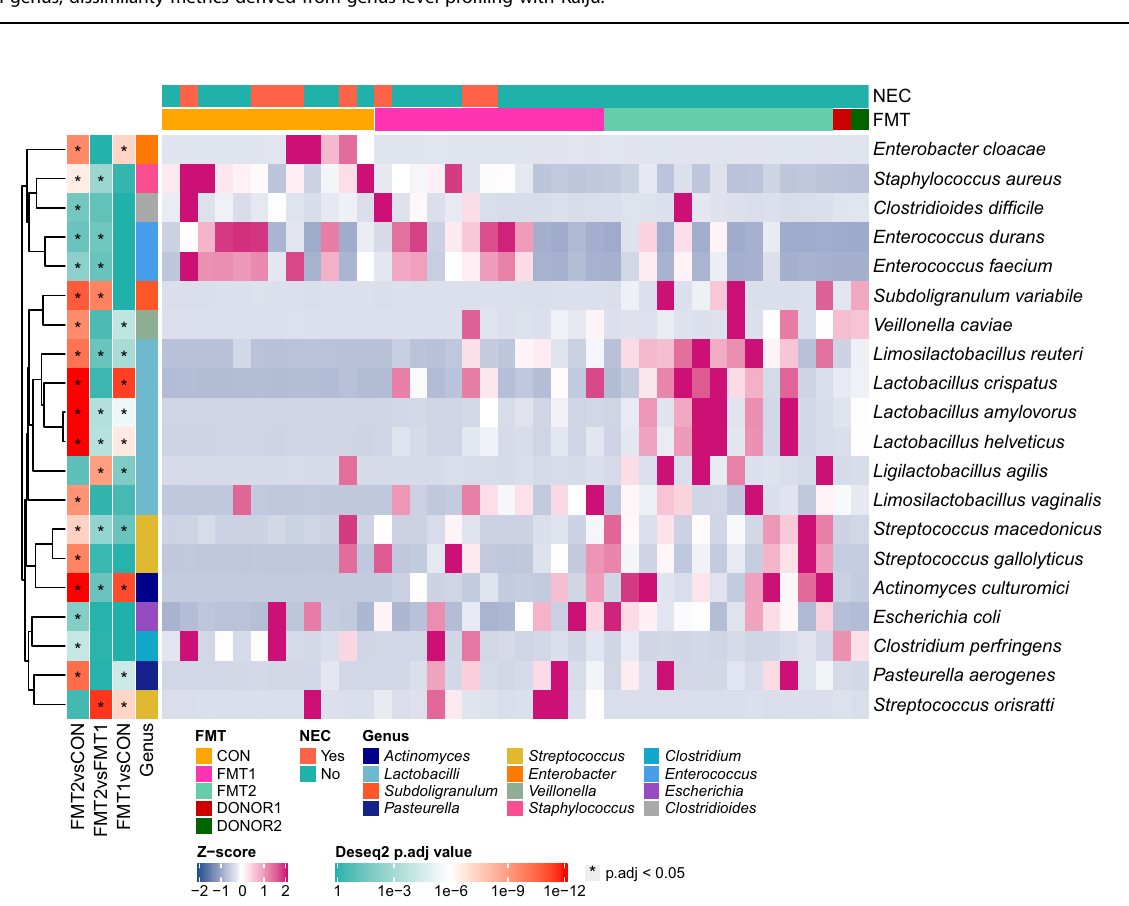
Fig. 4 Differentially abundant taxa in colon between recipient groups. Differentially abundant core species (relative abundance > 1% among at least 10% of samples) are shown. The label of * represents adjusted p < 0.05 (Wald test with Benjamin-Hochberg correction). Respectively n = 13, 13, 12 for FMT1, FMT2 and CON. FMT1 rectal FMT with Donor 1, FMT2 rectal FMT with Donor 2, CON rectal FMT with sterile saline as control, NEC necrotizing enterocolitis. FMT, Fecal Microbiota